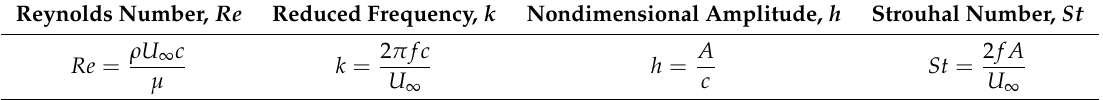
Table 1. Dimensionless